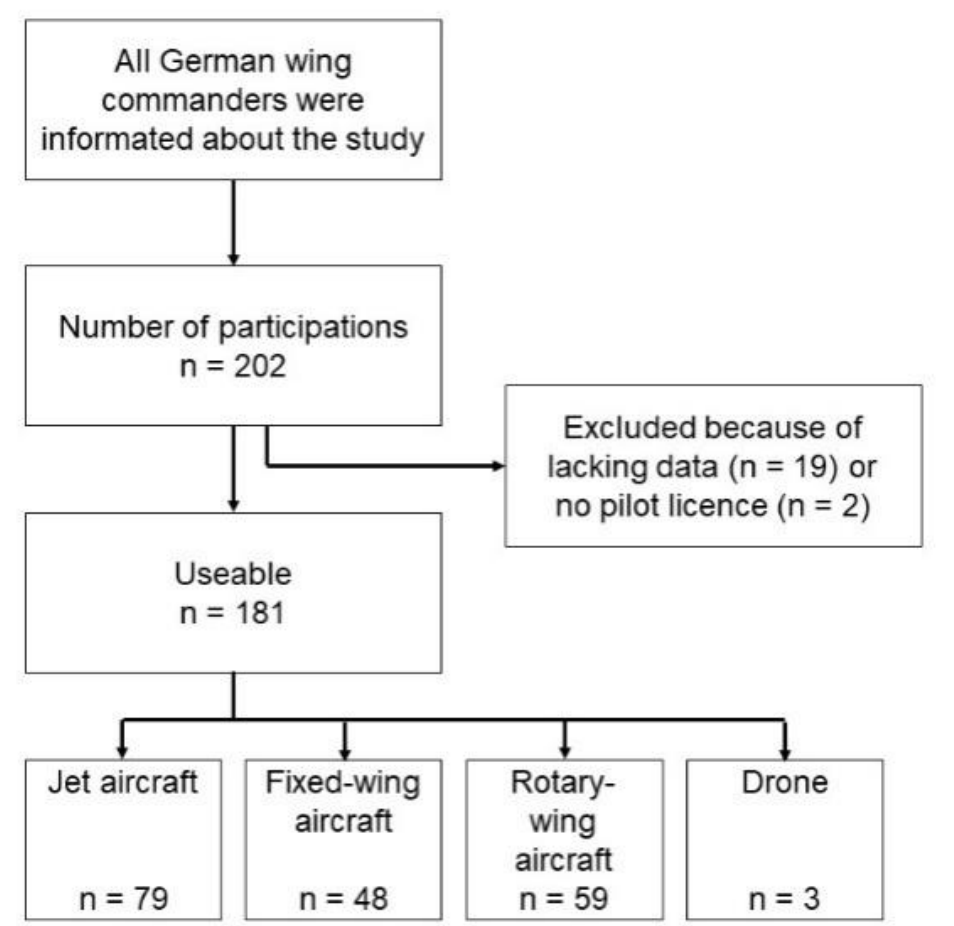
Figure 1. Process of test subject acquisition.